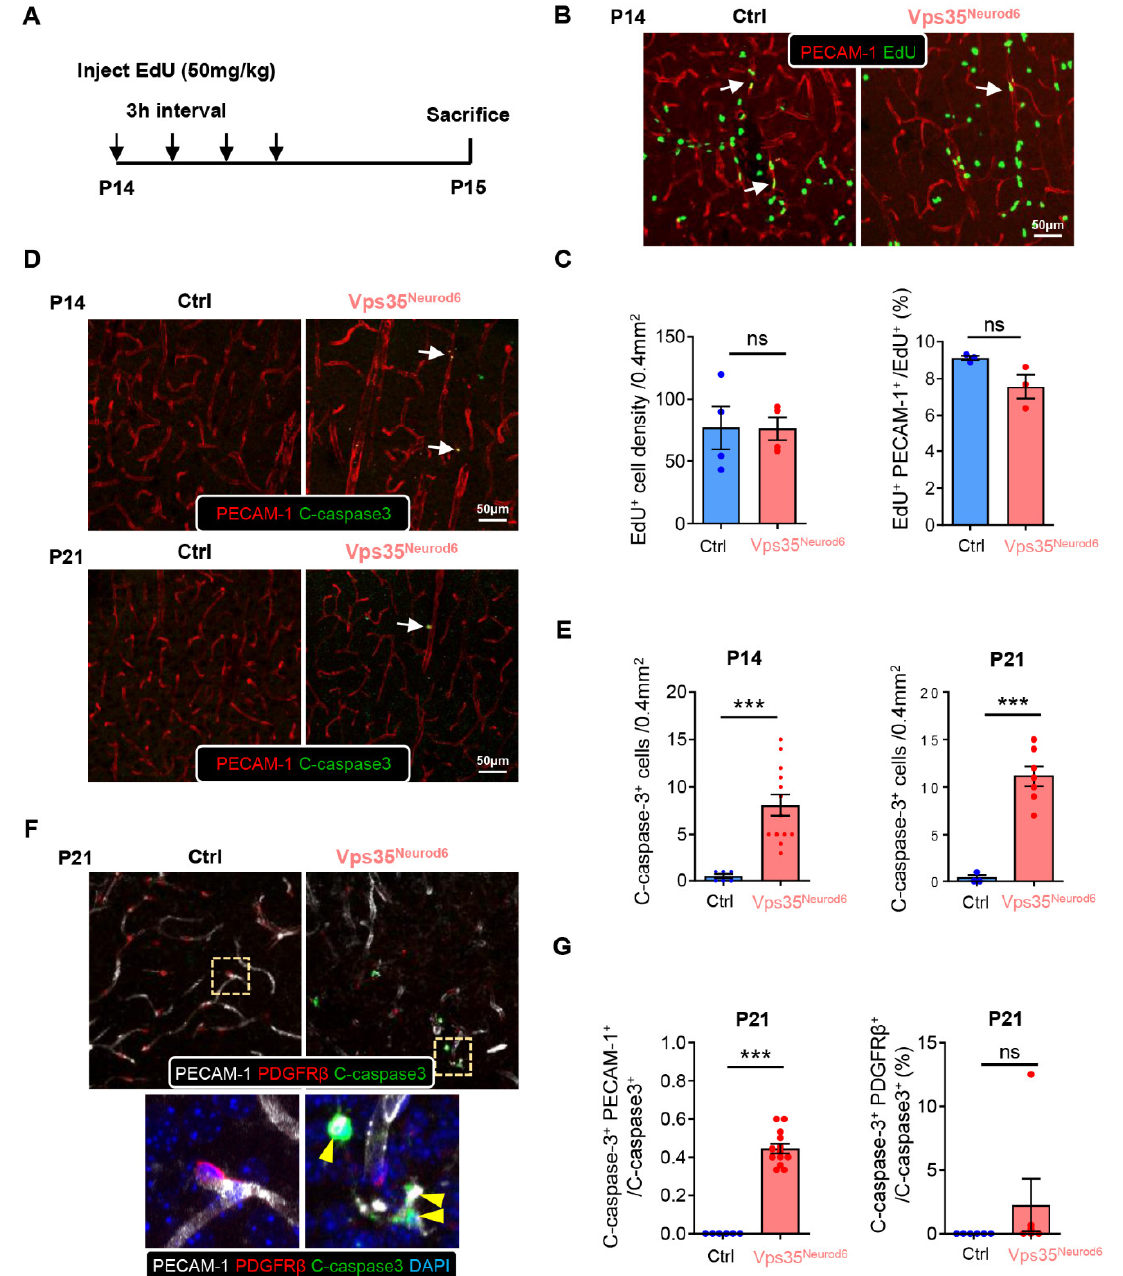
Figure 5. Comparable EC proliferation and increased apoptosis in Vps35 Neurod6 cortex at P14 and P21. ( A ) Schematic illustration of EdU injection protocol in control and Vps35 Neurod6 mice. ( B ) Representa- tive images of cortical brain sections coimmunostained with EdU (green) and PECAM-1 (red). ( C ) Quantification analyses of data in B (n = 3~4 mice per group; two-tailed unpaired t test). ( D ) Repre- sentative images of cortical brain sections coimmunostained with cleaved caspase3 (green) and PECAM-1 (red) at indicated age. ( E ) Quantification analysis of cleaved caspase3 + cells that showed an age-dependent increase in apoptotic cells in the Vps35 Neurod6 neocortex at indicated ages (n = 3~4 mice per group; two-tailed unpaired t test). ( F ) Representative images of cortical brain sections co- immunostained with cleaved caspase3 (green), PECAM-1 (white), and PDGFRβ (red) at P21; the nuclei were stained with DAPI (blue). Higher-magnification images of the boxed regions are shown in the lower panels. ( G ) Quantification analysis of cleaved caspase3 + endothelial cells and PDGFRβ + pericytes that showed an increase in apoptotic endothelial cells in the Vps35 Neurod6 neocortex at P21 but not in pericytes (n = 3~4 mice per group; two-tailed unpaired t test). Scale bars as indicated in